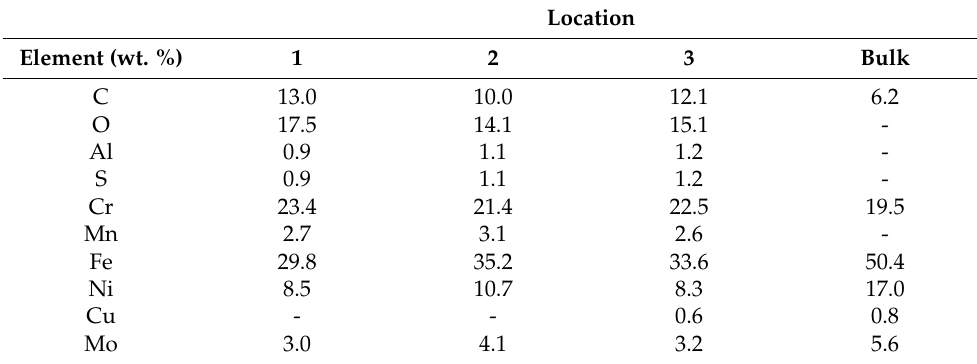
Table 10. EDX elemental analysis of locations shown in Figure 16. For comparison, an analysis of the bulk material after exposure at Reykjanes is included.